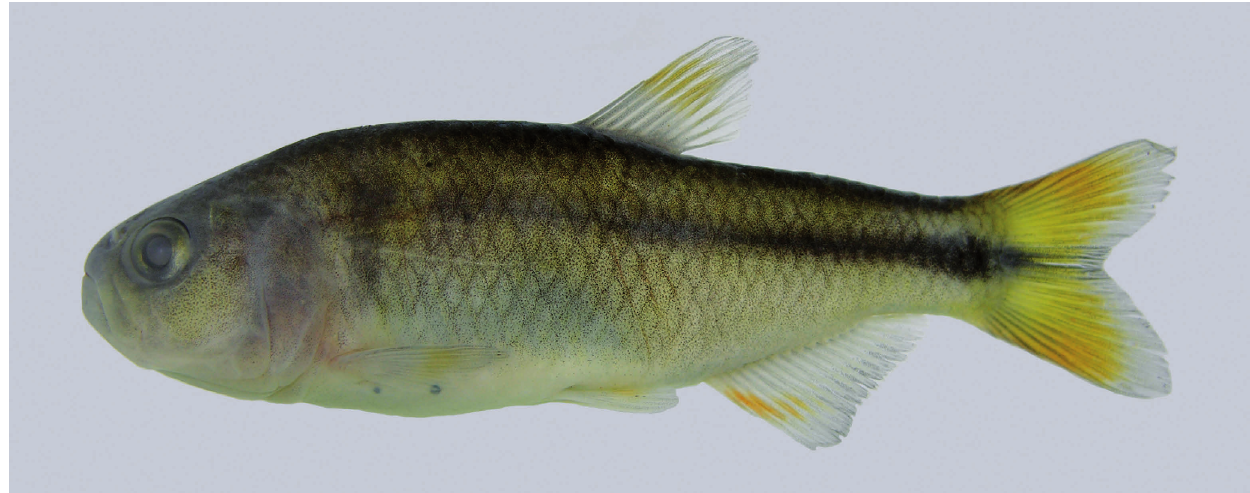
Fig. 1. Hasemania kalunga , MCP 44289, holotype, female, 53.3 mm SL; Brazil, Goiás State, Cavalcante, tributary of rio das Almas, rio Paranã drainage, upper rio Tocantins basin. Black spots below pectoral fin are nematodes’ cysts. Table 1. Morphometric data of holotype (H, female) and paratypes of Hasemania kalunga from the upper